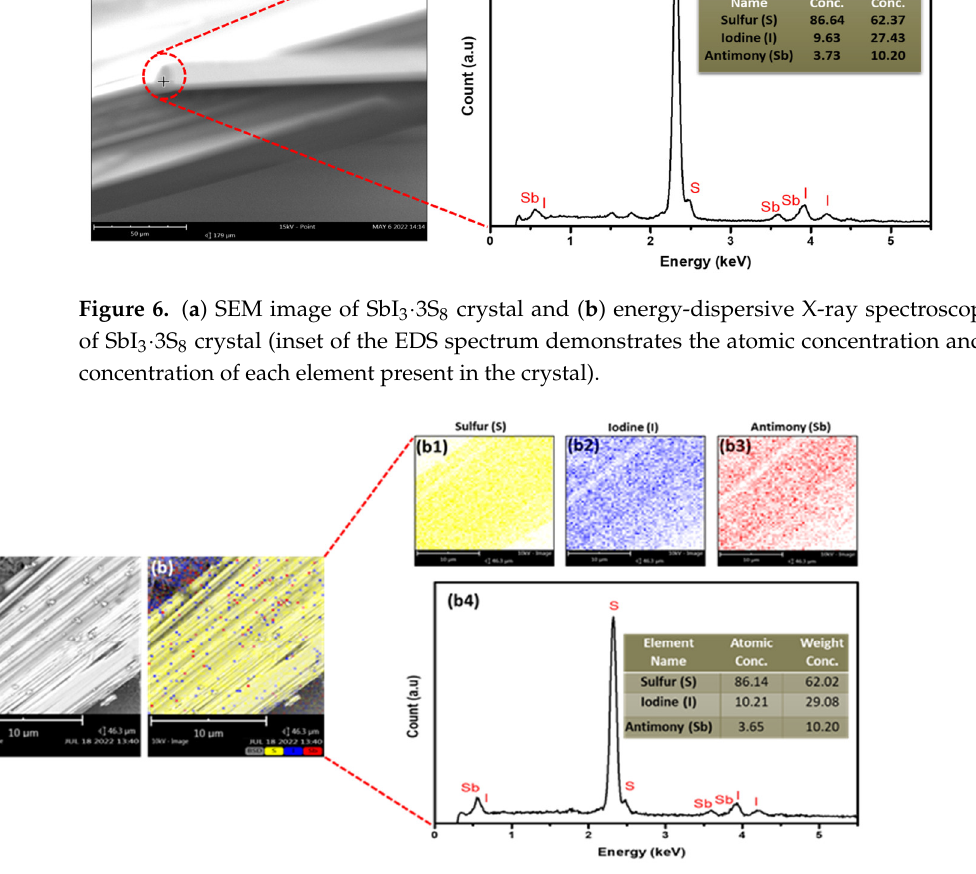
Figure 7. ( a ) SEM image and ( b ) EDS mapping and elemental analysis including ( b1 ) sulfur (S), ( b2 ) iodine (I), ( b3 ) antimony (Sb), and ( b4 ) EDS spectrum (inset shows the atomic concentration and weight concentration of each element present in the crystal) of the SbI 3 · 3S 8